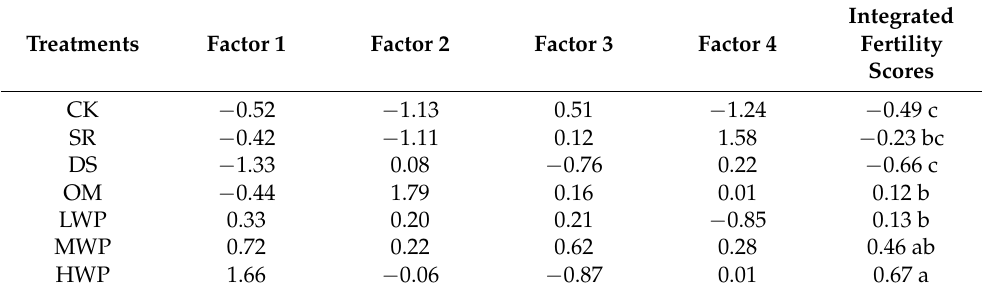
Table 5. Principal component scores and integrated fertility scores of soil fertility under different treatments in